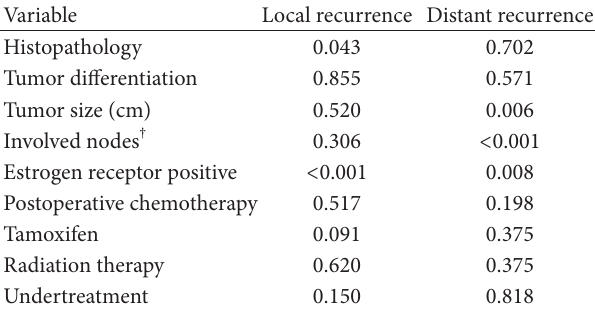
T 6: Cox regression of potential prognostic factors in patients over 70 ( 𝑃𝑃